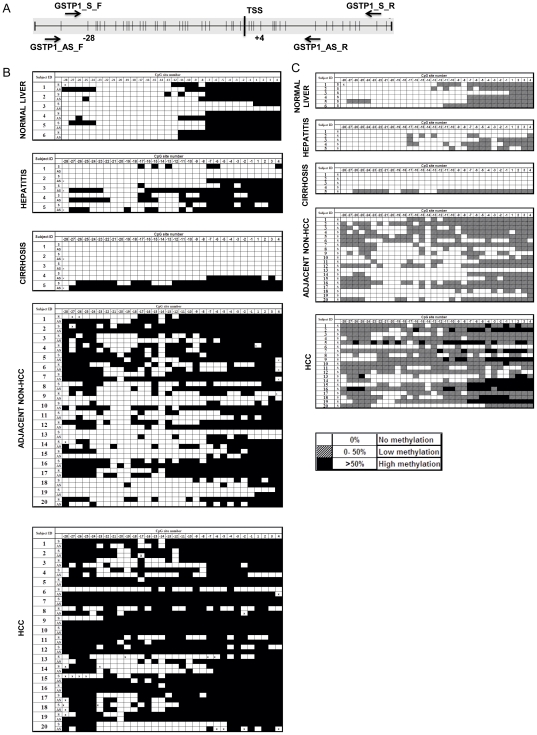
Methylation profiles of the sense and antisense strands of the GSTP1 gene by BSP sequencing of DNA isolated from normal liver and diseased liver tissues.(A) Diagram of the locations of bisulfite sequencing primers and the CpG sites, indicated by vertical bars, in the promoter and the first exon regions of the GSTP1 gene (Genbank accession #M24485, nt. 999–1387). The transcription start site (TSS) is also indicated. The CpG sites are bracketed by the bisulfite sequencing primers for the forward (F) and reverse (R) sense strands (GSTP1_S_F and GSTP1_S_R) and the antisense strands (GSTP1_AS_F and GSTP1_AS_R). (B) Methylation status of each CpG site in both sense (S) and antisense (AS) strands of the promoter and the first exon regions of the GSTP1 gene from −28 to +4 on the basis of the sense strand 5′ to 3′ direction relative to TSS in hepatocellular carcinoma (HCC, n = 20) tissue, matched adjacent non-HCC liver tissue (Adj Non-HCC, n = 20), and normal (n = 6), hepatitis (n = 5), and cirrhosis (n = 5) tissues. The filled boxes indicate methylation detected and open boxes indicate no methylation detected. (C) Analysis of the extent of methylation at each CpG site of the sense strand GSTP1 gene by BS-PCR sequencing of DNA isolated from normal liver and diseased liver tissues. CpG site locations, BS-PCR sequencing assay, and DNA samples are the same as in panel B. The filled boxes indicate a high level of methylation detected (more than 50%); hatched boxes indicate a low level of methylation detected (50% or less); and open boxes indicate no methylation detected.